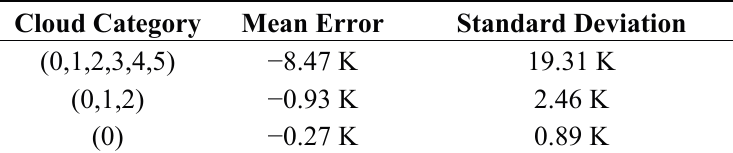
Table 2. Summary of results for Landsat 5 validation.